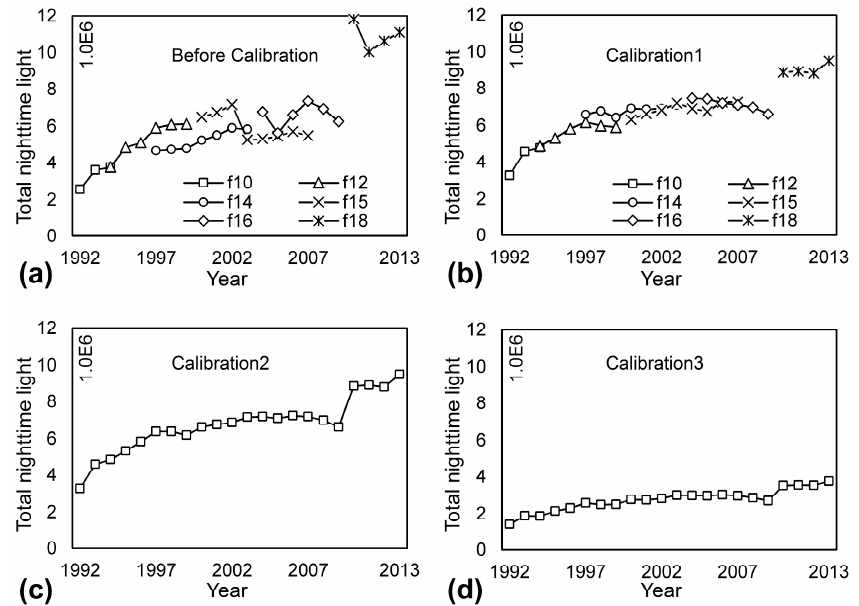
Figure 4. Comparisons of the results at different calibration stages for Southeast Asia: ( a ) Before calibration; ( b ) Calibration 1; ( c ) Calibration 2; ( d ) Calibration 3.